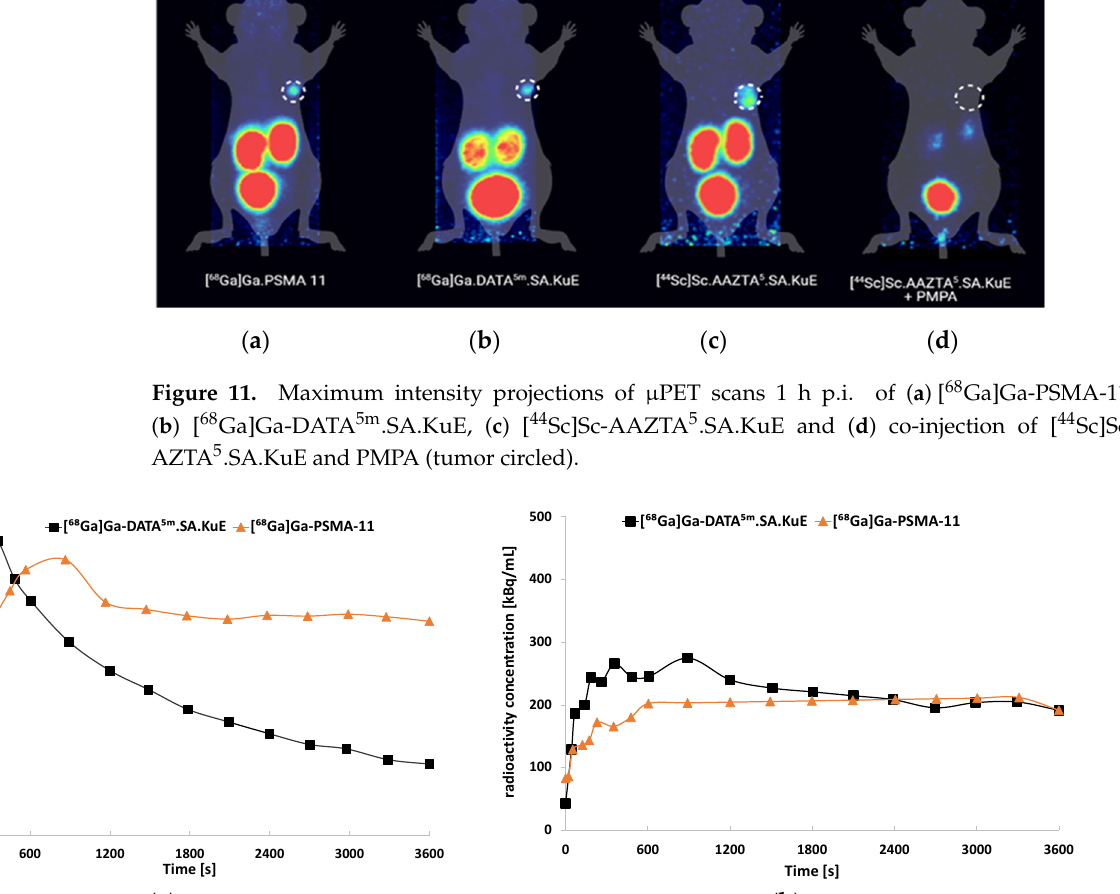
Figure 12. Time–activity curves of the uptake of [ 68 Ga]Ga-DATA 5m .SA.KuE and [ 68 Ga]Ga-PSMA-11 in the kidneys ( a ) and the tumor ( b ) over the total period of the µPET scan.